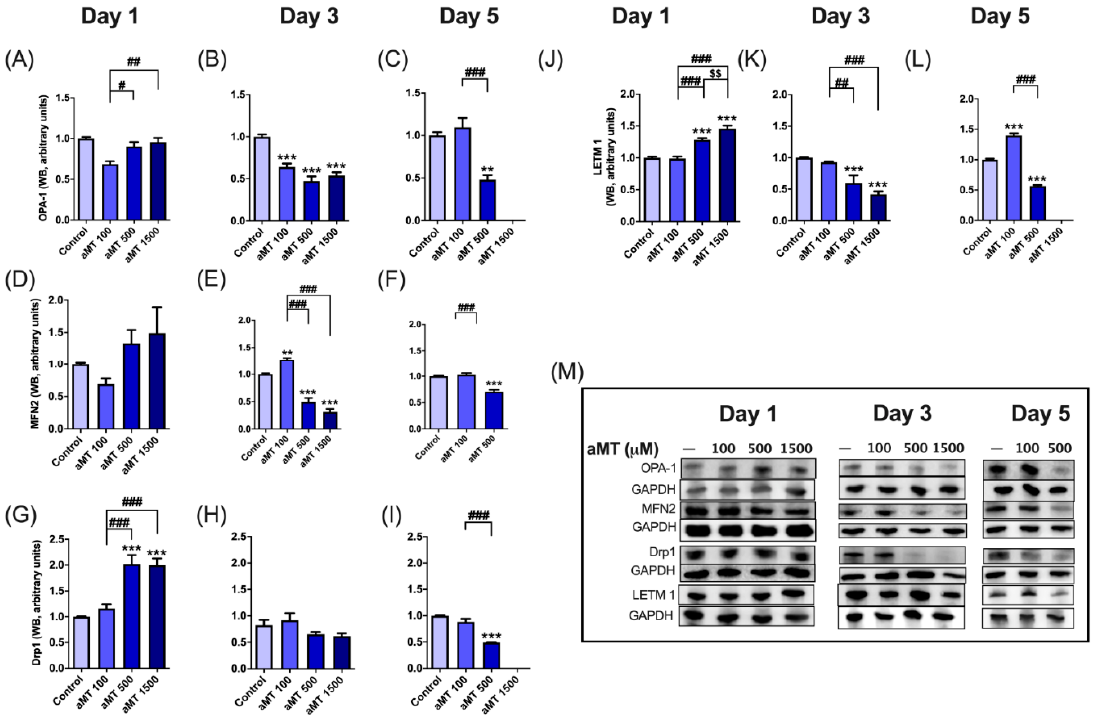
Figure 7. Melatonin-altered mitochondrial dynamics in Cal-27 cells. Western blot analysis of OPA-1 ( A – C , M ), MFN2 ( D – F , M ), Drp1 ( G – I , M ), and LETM1 ( J – L , M ). Data for aMT 1500 group are not shown at day 5 because most cells died. n = 6 per group. Data are presented as mean ± SEM. ** p < 0.01, *** p < 0.001 vs. control; # p < 0.05, ## p < 0.01, ### p < 0.001 vs. aMT 100 µM group; $$ p < 0.01 vs. aMT 500 µM group.